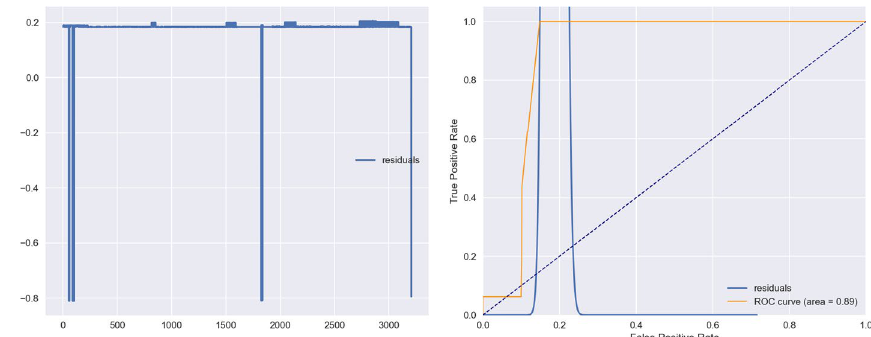
Fig. 2 Results of applying XGBoost to D20 only. Left: residual sequence with original timed order. Right: ROC curve and residual distribution